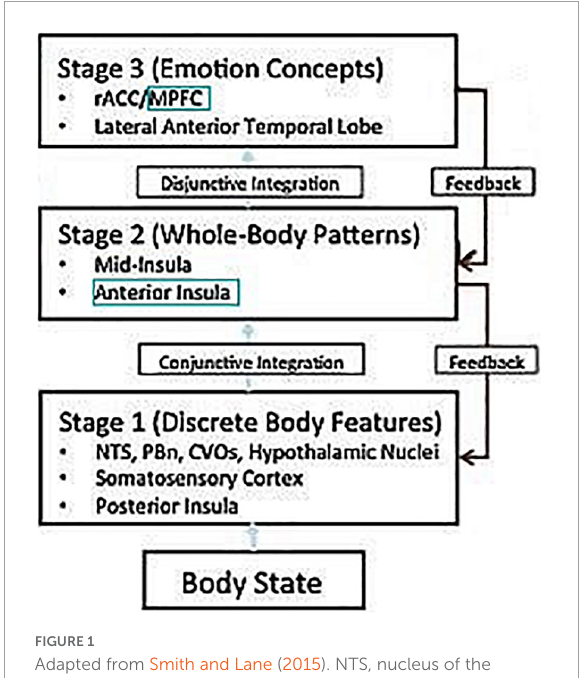
FIGURE1 Adapted from Smith and Lane (2015). NTS, nucleus of the solitary tract; PBn, parabrachial nucleus; CVOs, circumventricular organs; rACC, rostral ACC; MPFC, medial prefrontal